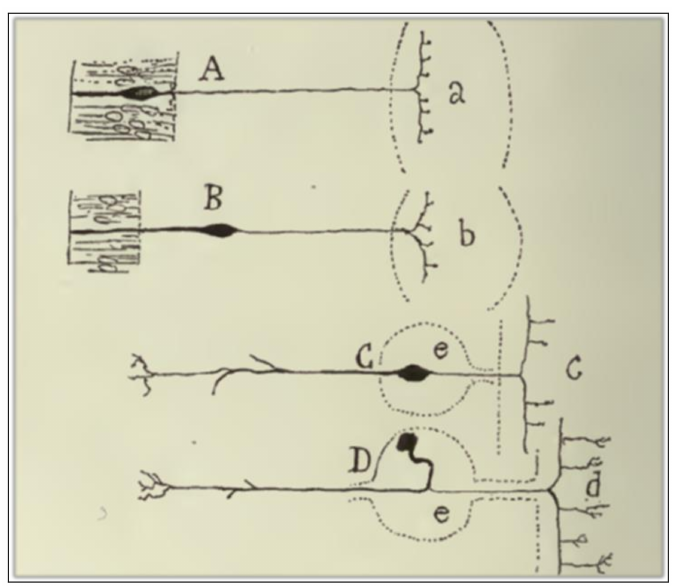
Figure 4. A scheme that shows the changes in placement and morphology of sensitive ganglion cells in the animal series. ( A ) Sensitive cells of the earthworm; ( B ) sensitive cells from mollusks; ( C ) sensitive cells from fish; ( D ) sensitive cells from mammals, birds, reptiles, and frogs. Taken from Cajal [30] (p. 194); out of copyright.